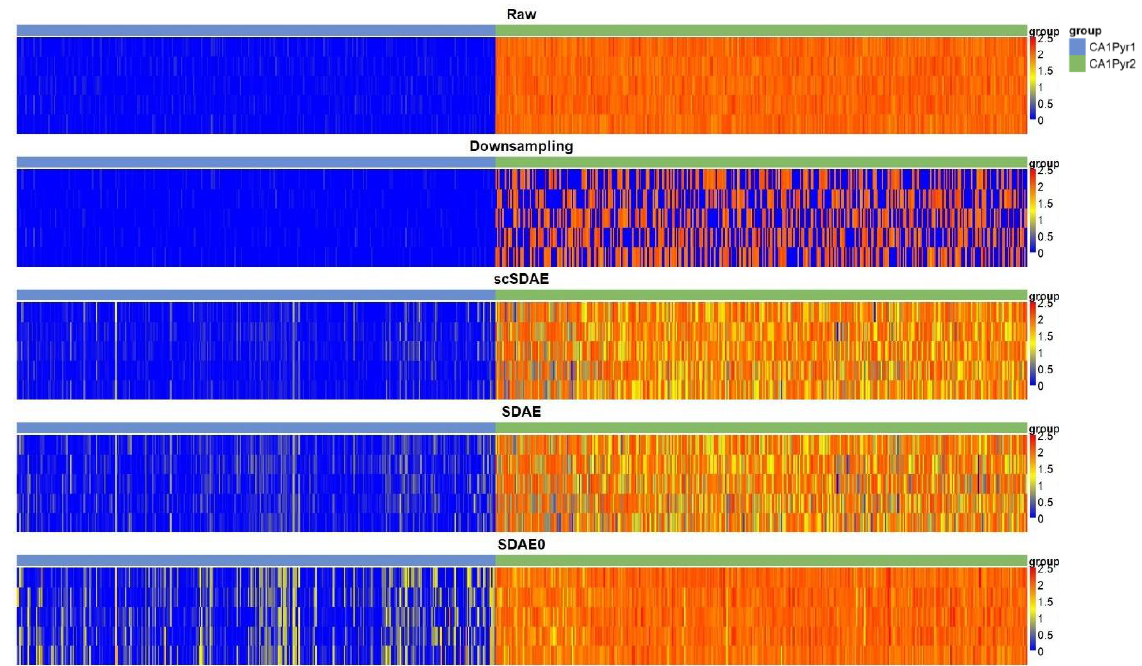
Figure 6. The heatmaps of five artificial genes with 50% zeros in the CA1Pyr1 and CA1Pyr2 groups are shown. The vertical axis represents the artificial genes, and the horizontal axis stands for the cells. True values in the CA1Pyr1 group are close to zero, while true values in the CA1Pyr2 group are high. scSDAE imputed least false positive values in the CA1Pyr1 group.